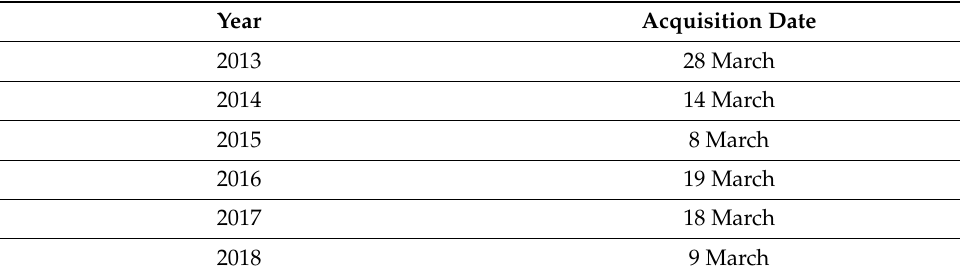
Table 1. Dates of images acquired for inter-annual